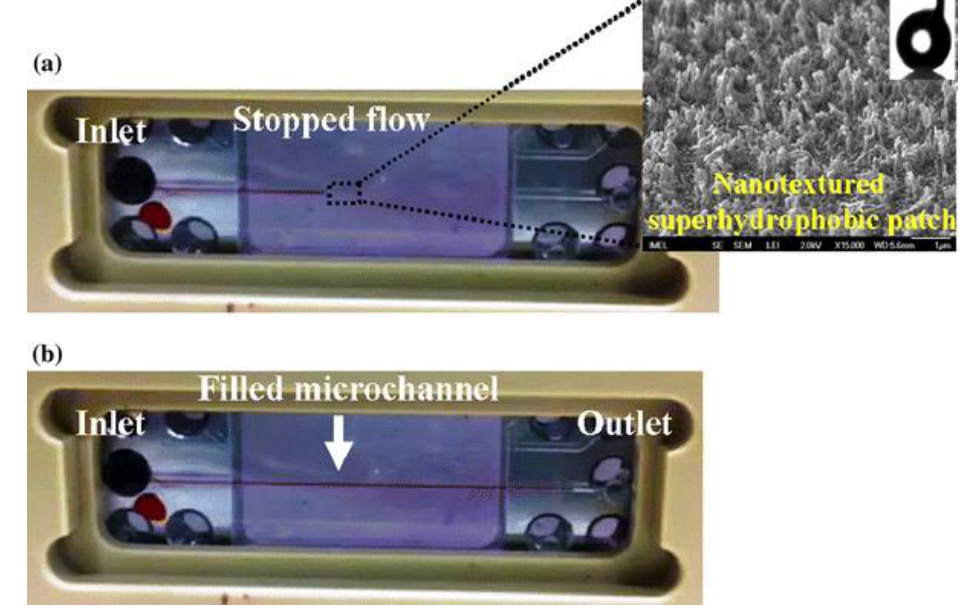
Figure 3. Passive super-hydrophobic microvalve: The hydrophobic zone is placed in the middle of the microchannel (SEM image in the inset). ( a ) Stopped fluid flow (red dye) at the nano-textured hydrophobic zone, ( b ) filled microchannel upon valve opening. Reprinted with permission from [65]. Copyright 2014 Springer-Verlag Berlin Heidelberg.